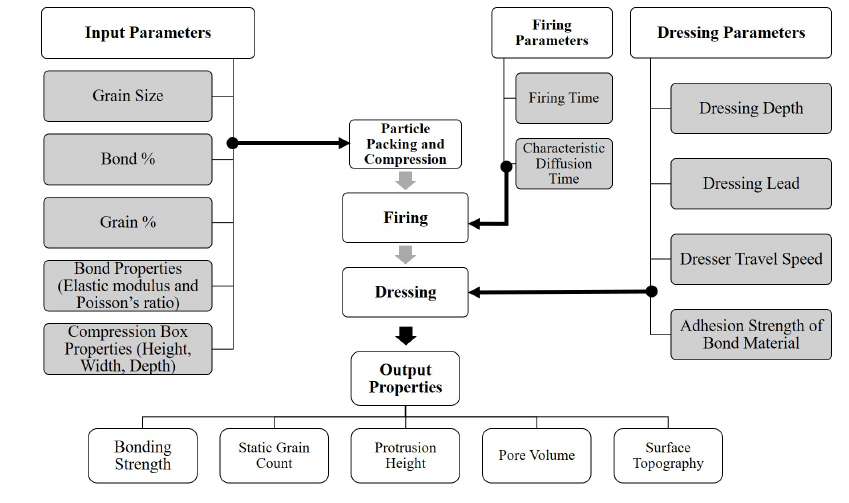
Figure 5. Input parameters and output properties of simulation; partly adapted based on